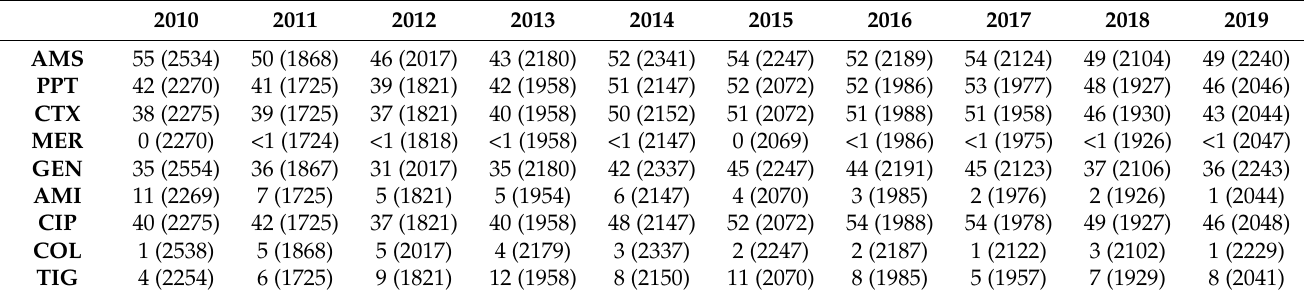
Table 4. Resistance of Klebsiella pneumoniae to antibiotics at the University Hospital Olomouc in